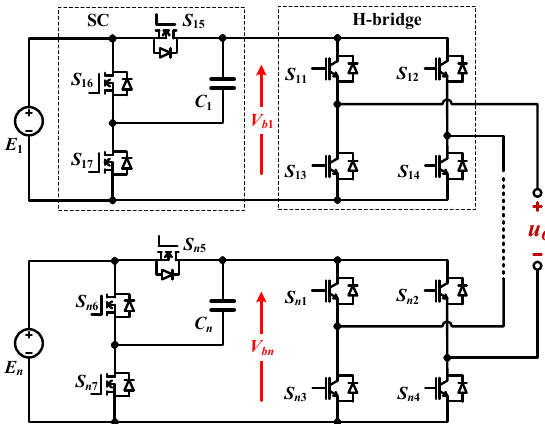
Figure 1. Cascaded switched-capacitor multilevel converter.